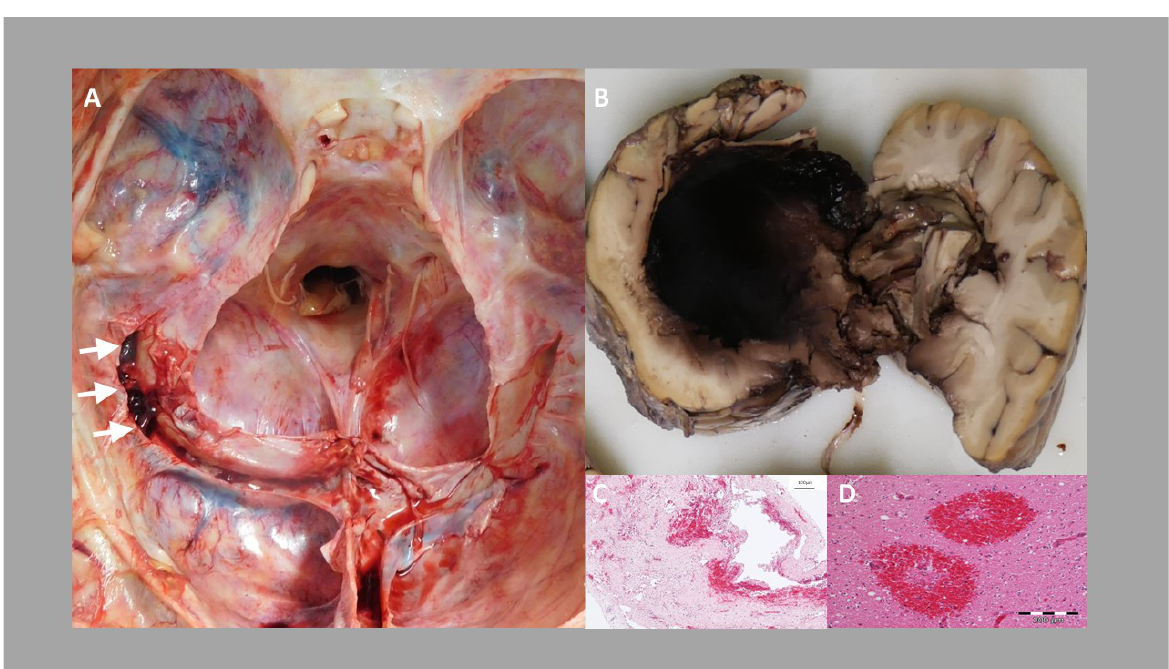
Figure 5. ( A ) Post-mortem diagnosis of left transverse sinus rope-ladder-like organized thrombus (arrows). ( B ) Left-side intracranial hemorrhage with perifocal edema. ( C ) shows fibrous tissue with erythrocyte accumulation comparable with organized thrombus formation. ( D ) Photomicrograph of fresh perivascular hemorrhages in the occipital